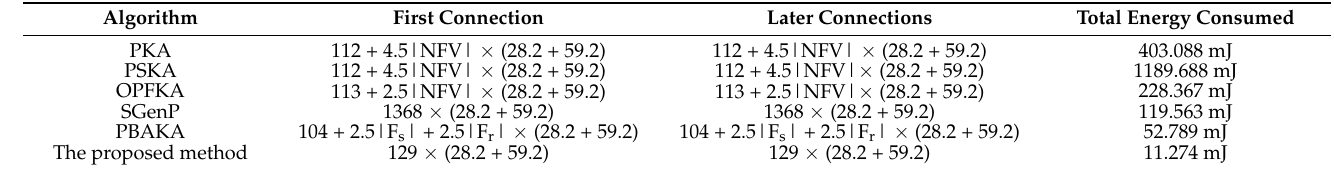
Table 7. The energy consumption for first/later connections.